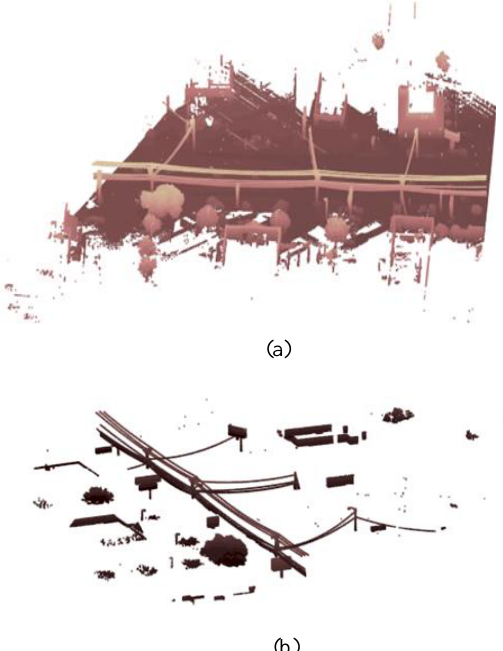
Figure 9. Low-Height Filtering step in order to eliminate unneeded objects. (a) A sample of the created sections; (b) Eliminating unneeded objects such as ground